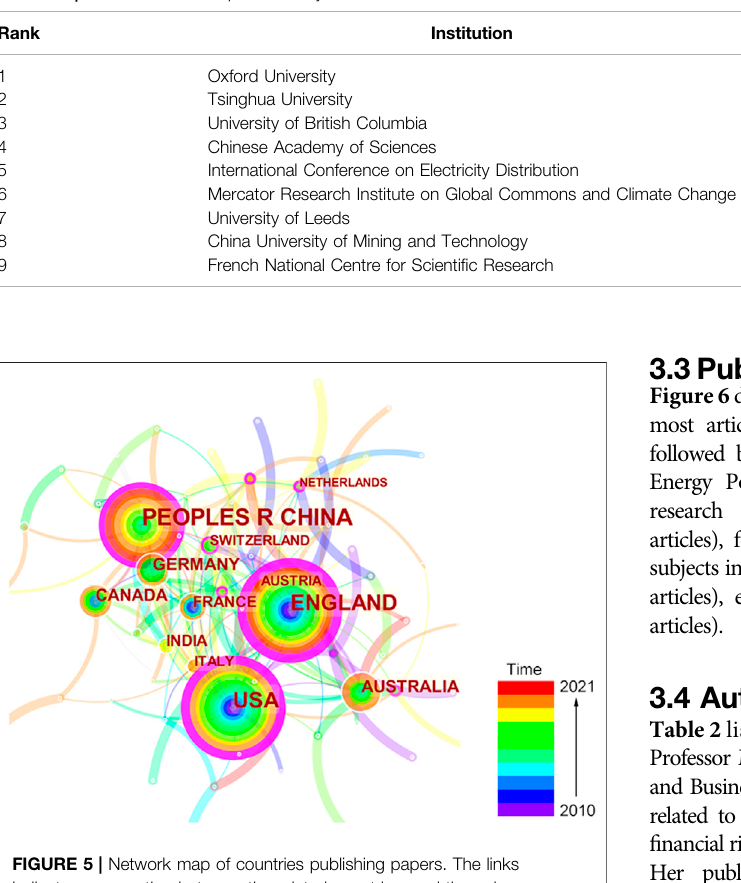
TABLE 1 | Number of articles published by